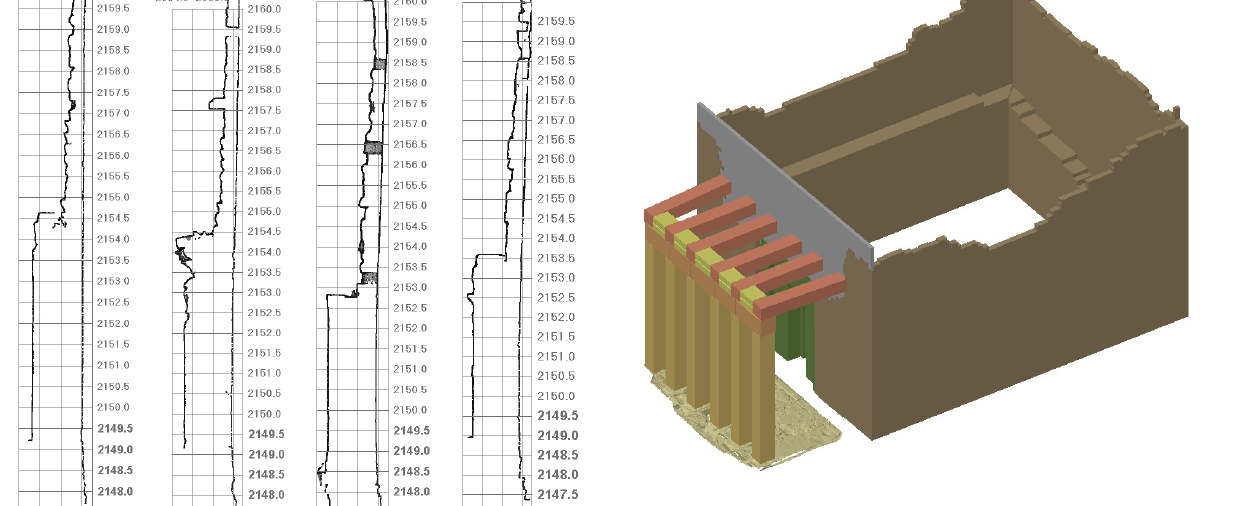
Figure 9: Reconstructed propylon and masonry with the current status of the facades in